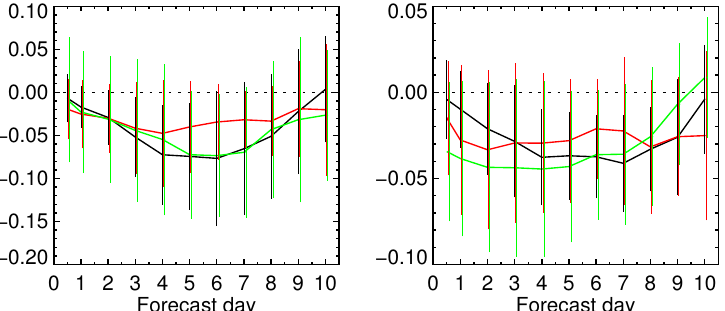
Figure 9. Near-surface air temperature ( left ) and air humidity ( right ) normalized root mean square forecast error of SLV (black curve), SMOS (red curve) and SLV+SMOS (green curve) experiments compared to the control OL experiment, as a function of the forecast lead time. The operational analyses are used as reference. Error bars show 95% confidence intervals.